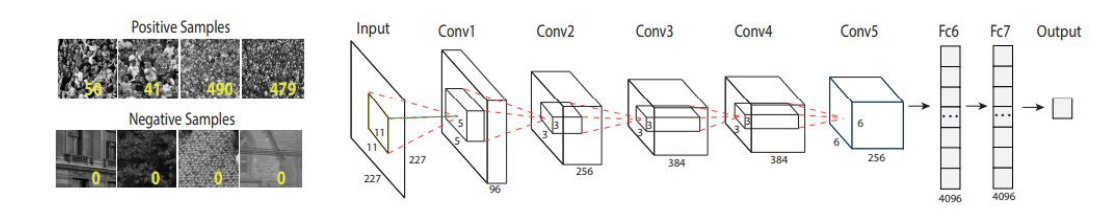
Figure 3. Convolutional Neural Network (CNN) architecture with positive and negative inputs. Image from